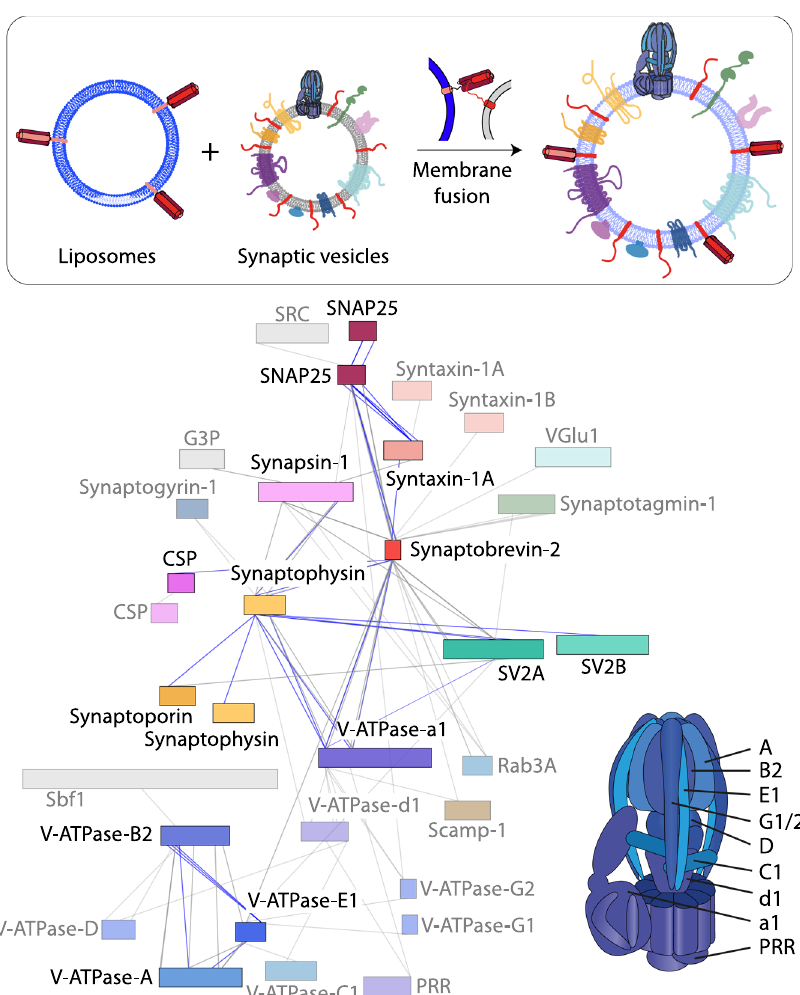
Fig. 5 Protein interaction network of synaptic vesicles after fusion with Δ N-SNARE-proteoliposomes. Top schematic: Synaptic vesicles were fused with Δ N-SNARE-proteoliposomes. During membrane fusion, vesicular Synaptobrevin-2 integrates into the SNARE complex. Fused vesicles provide a more spacious membrane environment. Network: Synaptic vesicle proteins are shown as coloured bars; contaminants are shown as grey bars. The length of the bars represents the protein length. The N-terminus is on the left and the C-terminus is on the right side of the bar. Inter-molecular cross-links identi fi ed in one (grey) or at least two (blue) biological replicates are shown. Proteins that are linked through interactions from only one biological replicate are transparent. A structural cartoon of the V-ATPase is shown for comparison. V-ATPase subunits identi fi ed in this interaction network are